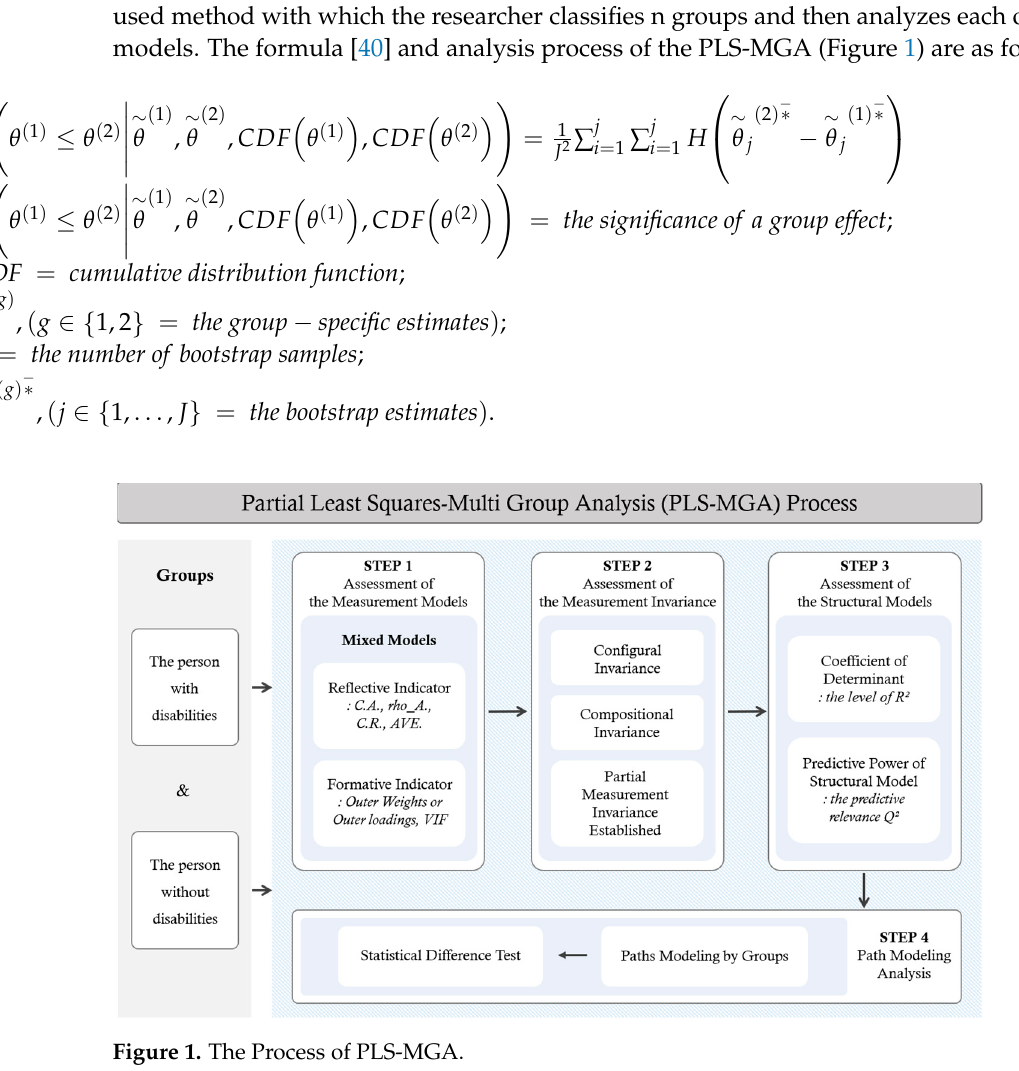
Figure 2. Conceptual research model.